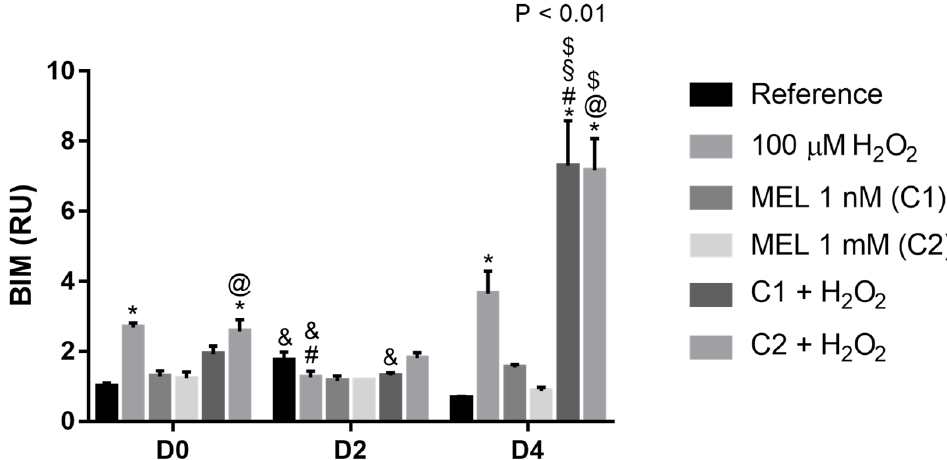
Figure 7. Relative expression of BIM in K562 erythroid cells. Reference: K562 cells without induction